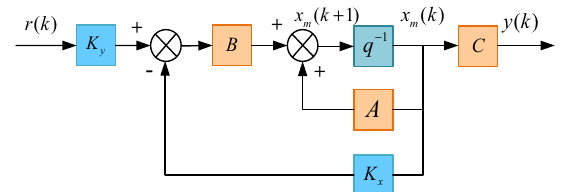
Fig. 3 Input parameters and output power of model identification